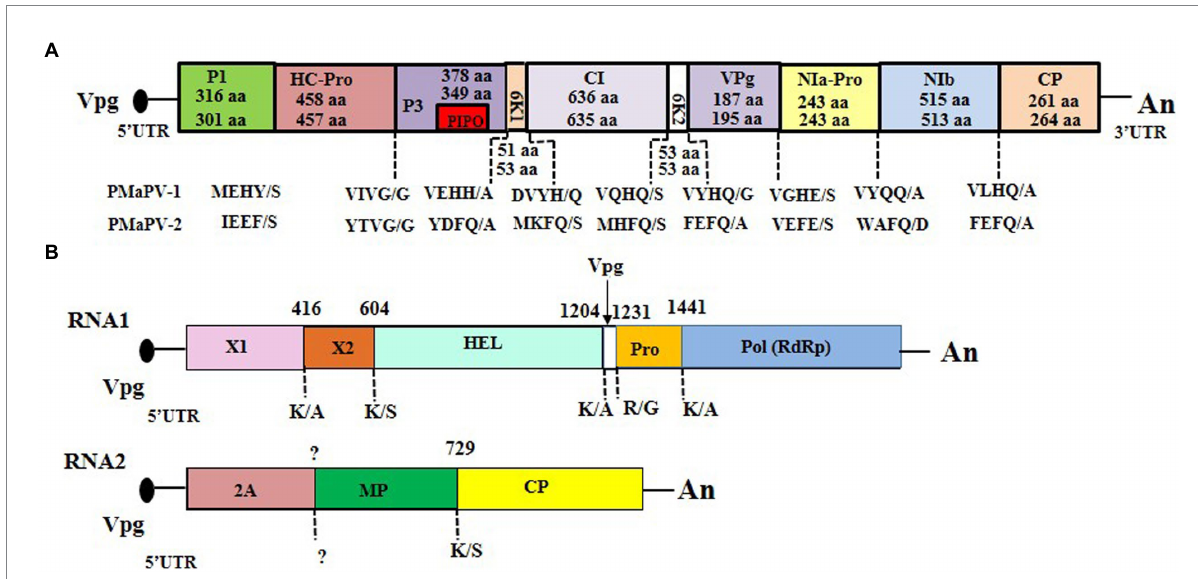
FIGURE. 3 Genome organization of the three novel viruses: (A) Paris potyvirus 3 (ParPV-3) (above) and ParPV-4 (below), (B) Paris nepovirus 1 (ParNV-1). The 5 ′ - and 3 ′ -untranslated regions (UTR) are represented by a solid line, and the open reading frame (ORF) is depicted by an open box with solid line. The putative protein of PIPO within the P3 of ParPV-3 and ParPV-4 is indicated with a small box in red. The putative proteinase cleavage sites in the polyprotein of the three viruses were labeled below the genome. The size of each protein in ParPV-3 and ParPV-4 are indicated whereas the numbers above the genome of ParNV-1 indicate the start for each